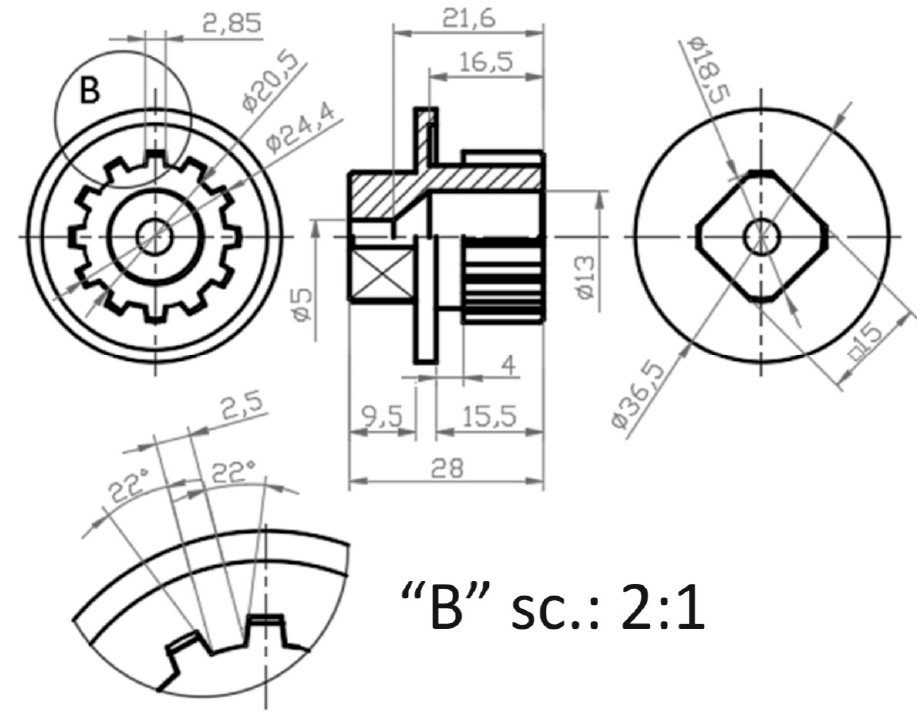
Figure 2. The execution sketch of the grooved shaft [3].